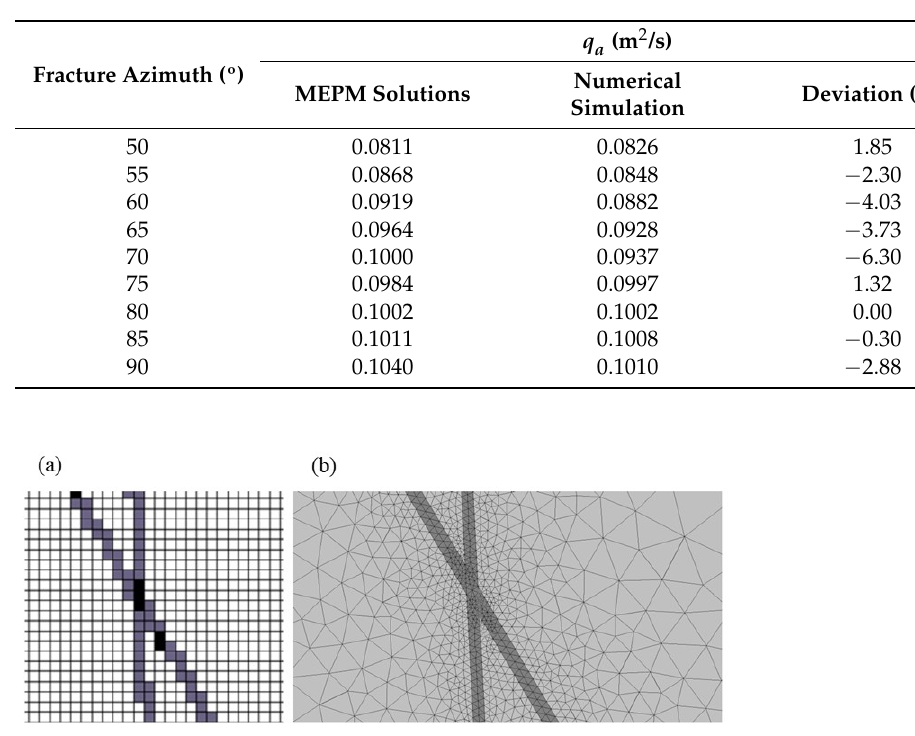
Table 5. Comparison of the simulation results for different simple fracture networks with numerical solutions from the MEPM [63].